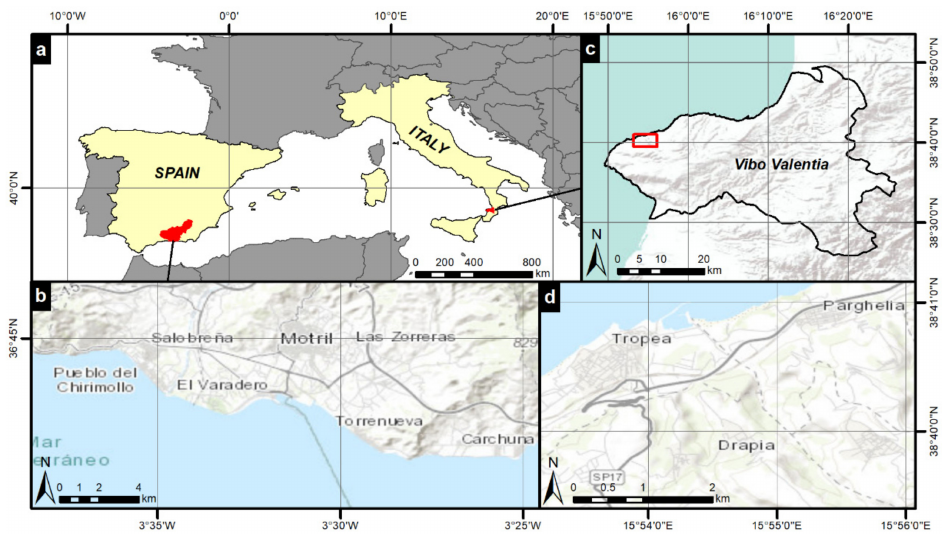
Figure 14. ( a ) Location of the real test cases in the province of Granada (Spain) and Vibo Valentia (Calabria, Italy); ( b ) Detail of the test area located in the Granada coast. ( c ) Test site of Vibo Valentia; and ( d ) Detail of the test area of Vibo